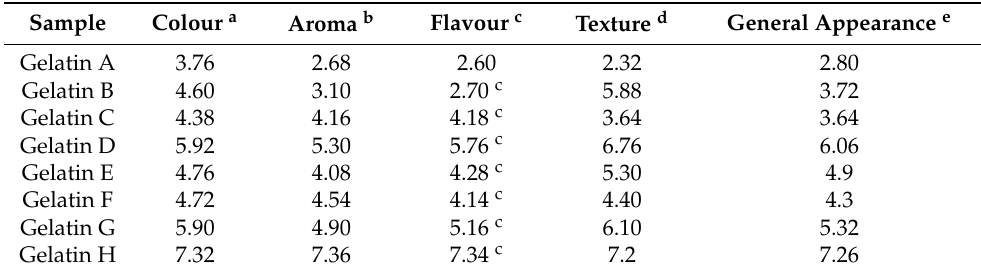
Table 3. Results of statistical analysis of gelatin